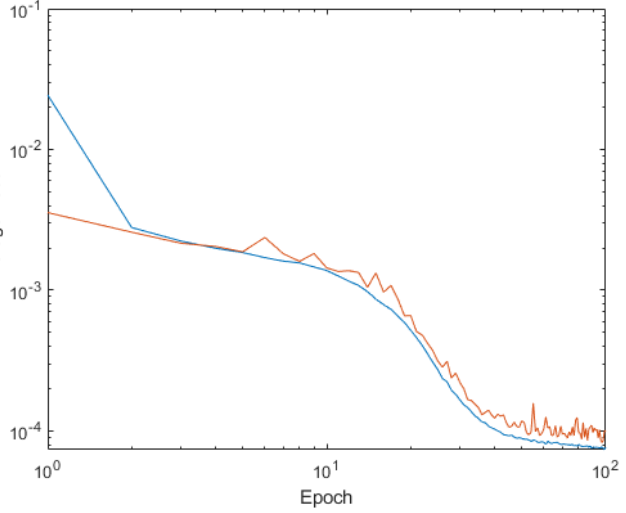
Figure 8. Average loss on training patterns in blue and validation patterns in orange for the Dynamic drop-out and Dynamic alpha SGD of Mexican Hat.